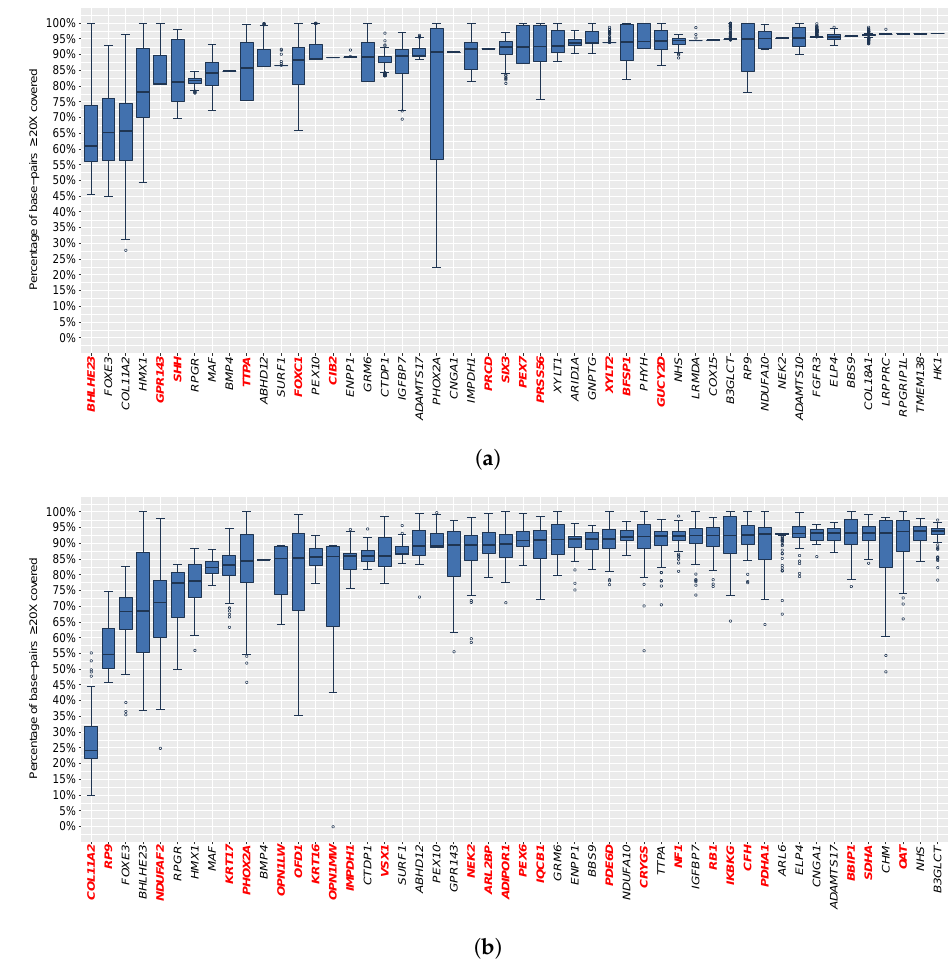
Figure 3. Overview of 50 genes with the lowest coverage. The boxplots depict the percent distribution of exonic regions with at least 20 × coverage for the hereditary eye disease enrichment panel capture ( a ) and whole exome sequencing libraries ( b ). The poor coverage in a total of 27 genes was consistent for the two different capture methods. Some genes in one enrichment capture platform had coverage lower by more than 5% of the targeted regions than that in the other platform. These genes are highlighted in red and by bold